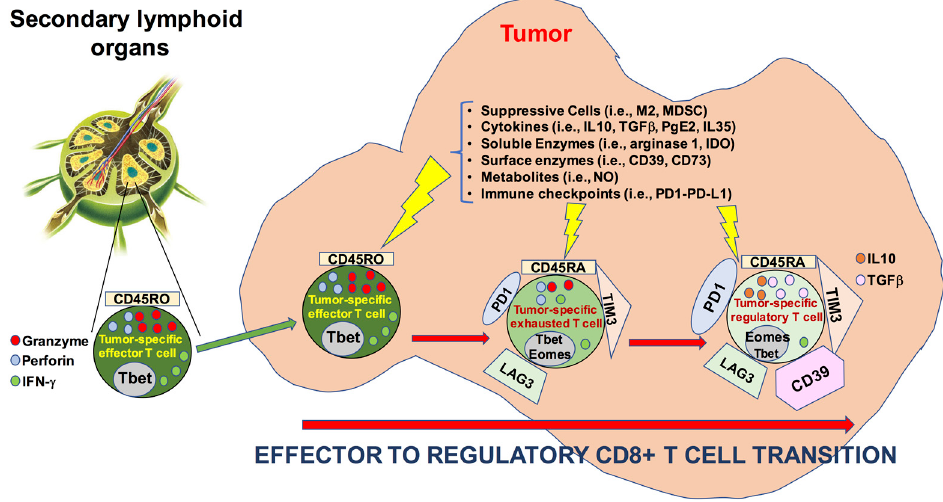
Figure 6. Schematic representation of the “effector-to-regulatory CD8+ T cell transition” at the tumor site.